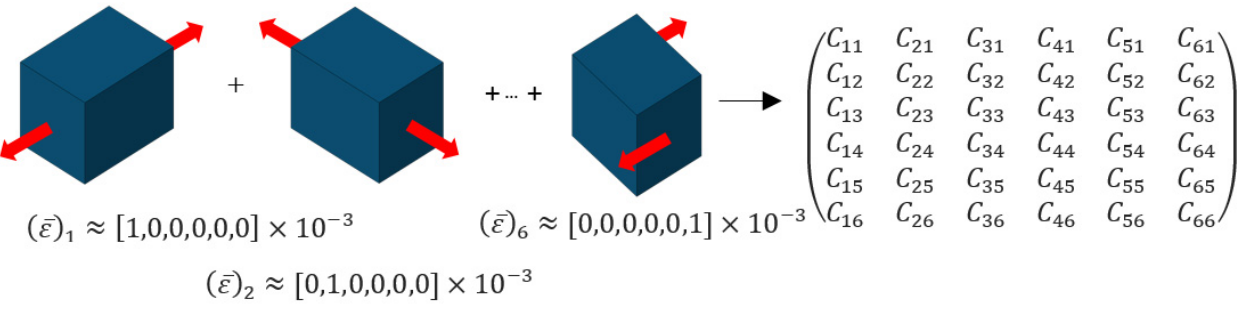
Figure 1. Illustration of combined deformations to determine complete stiffness tensor.